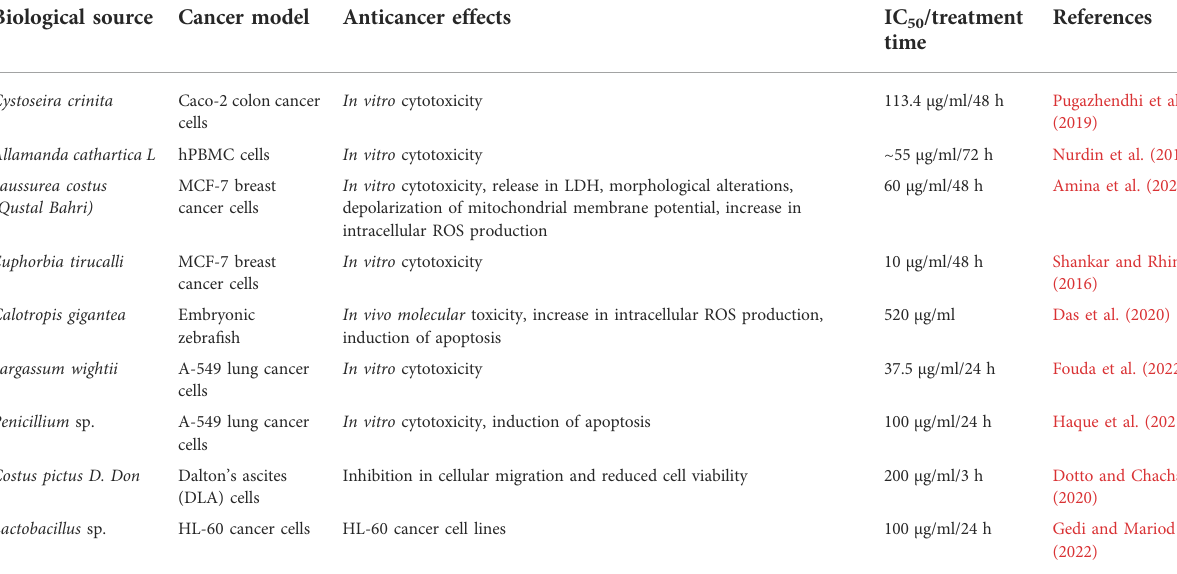
TABLE 1 Comparative ef fi cacy of green-synthesized MgONPs from various